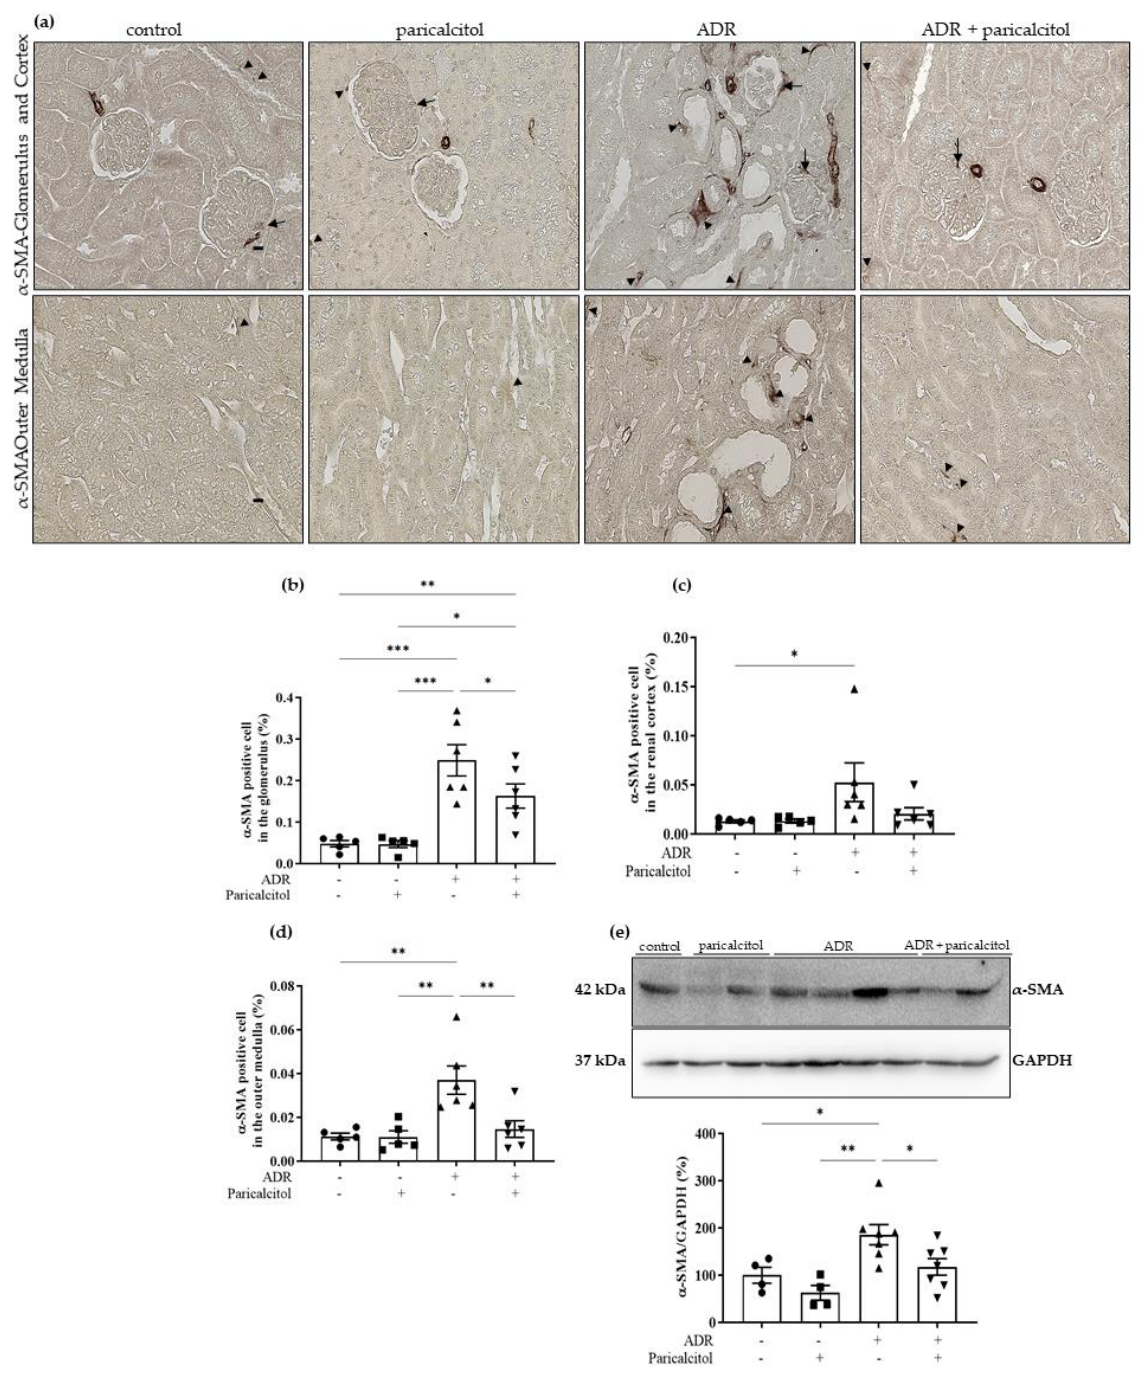
Figure 6. ( a ). The immunolocalization of α -SMA in all renal compartments. The arrows indicate the α -SMA-positive expression in the glomerulus. The arrowheads indicate the α -SMA-positive expression in the tubulointerstitial compartments. ( b ). Percentual of α -SMA-positive cells in the glomerulus. ( c ). Percentual of α -SMA-positive cells in the renal cortex. ( d ). Percentual of α -SMA-positive cells in the outer medulla. Immunohistochemical data are expressed as the mean ± SEM. Scale bar = 20 µ m, n = 5–6. ( e ). Densitometric ratios among α -SMA and GAPDH were calculated, and data were expressed compared with the control group. The control value was designated as 100%. Data are expressed as mean ± SEM. n = 4–7 for each group. Data from the control (dots), paricalcitol (squares), ADR (up triangles), and ADR + paricalcitol (down triangles) groups. * p < 0.05; ** p < 0.01; *** p <